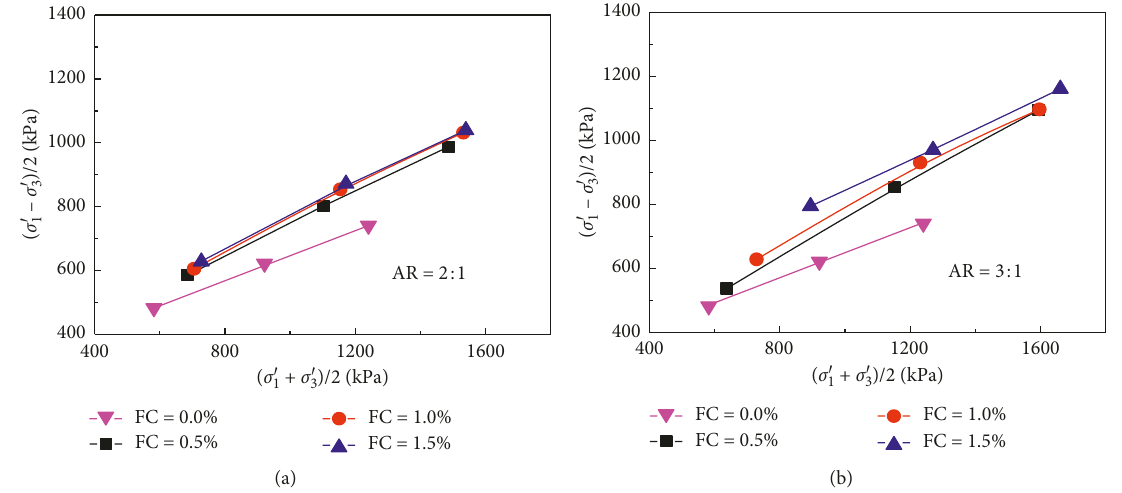
Figure 8: Shear strength envelope: (a) aspect ratio of 2:1; (b) aspect ratio of 3:1.